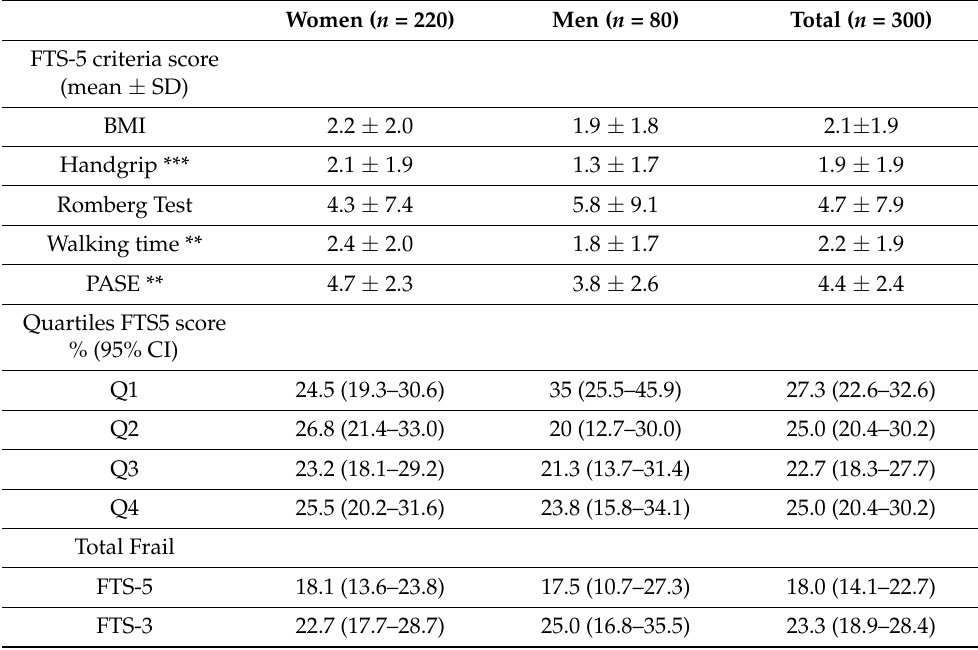
Table 3. Description of the frailty criteria of the FTS-5 and FTS-3 diagnostic